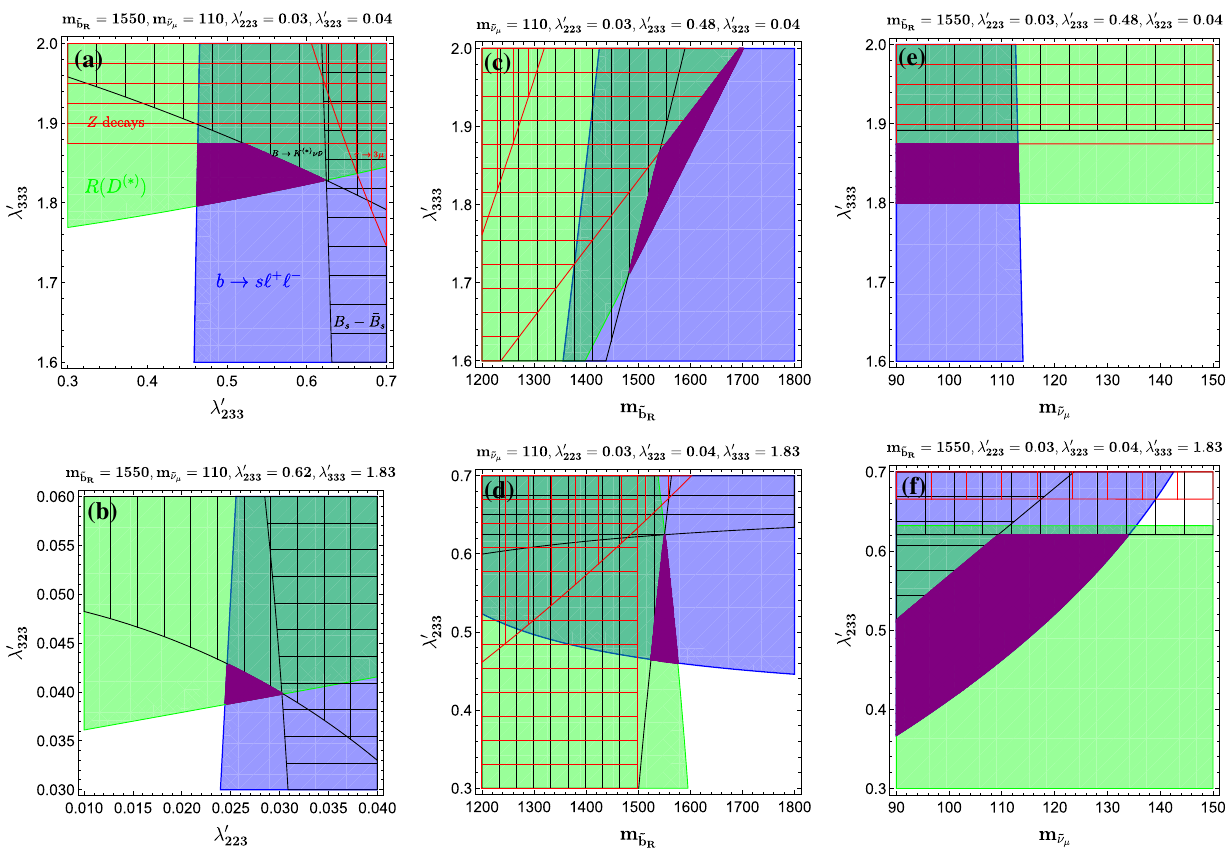
Fig. 3 Numerical analysis in which b → s (cid:2) + (cid:2) − and R ( D ( ∗ ) ) anoma- lies are solved and other constraints are satisfied. The masses m ˜ m ˜ ν are given in units of GeV. The 2 σ favored regions from the b → μ s (cid:2) + (cid:2) − and R ( D ( ∗ ) ) measurements are shown in blue and green, respec-